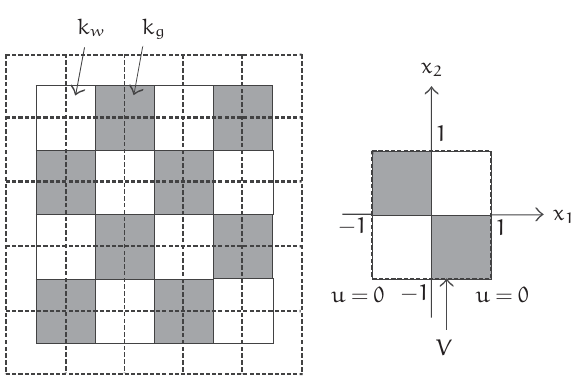
Figure 2.1. A part of a checkerboard with a quarter of a period , denoted V , shown to the